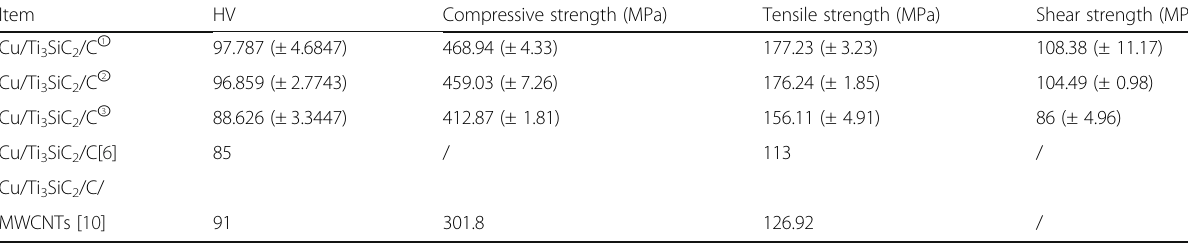
Table 4 Mechanical properties of nanocomposite materials